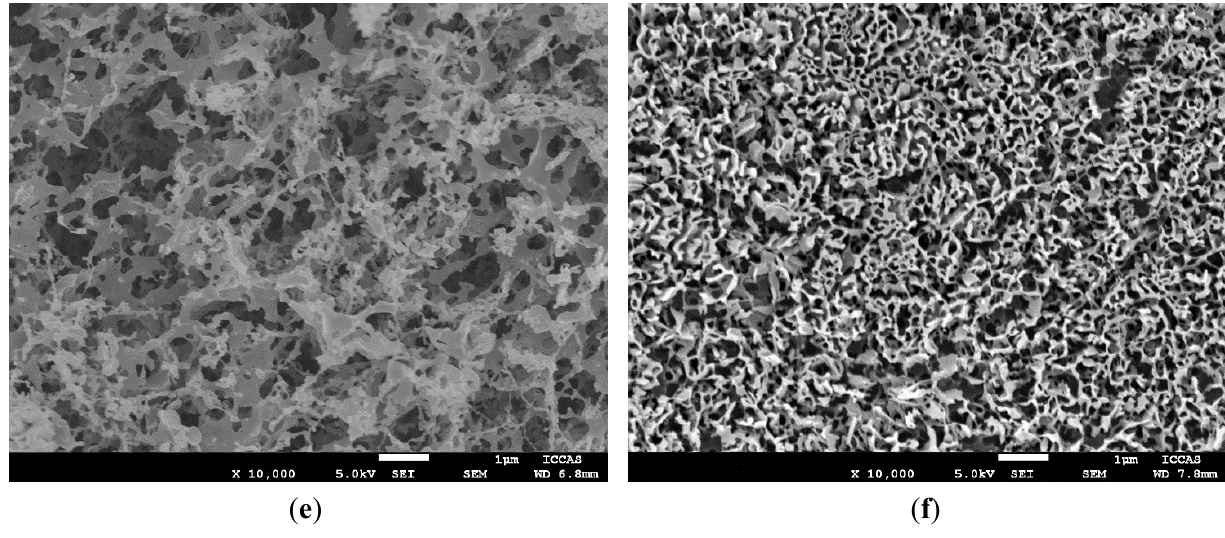
Figure 1. SEM images of the conductive polymer porous films prepared from different concentrations of polymer solutions: ( a ) 0.08%; ( b ) 0.1%; ( c ) 0.2%; ( d ) 0.4%; ( e ) 0.6%; and ( f ) 0.8%. The scale bar is 1 µm.